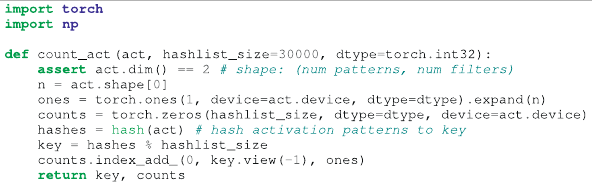
Algorithm 1 , which queries a hash list of activation